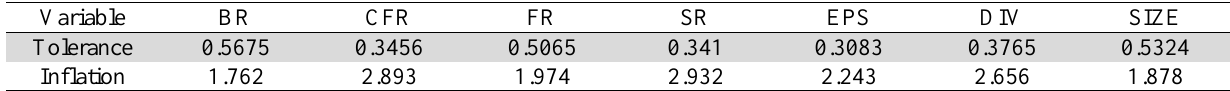
The summary of inflation of variance